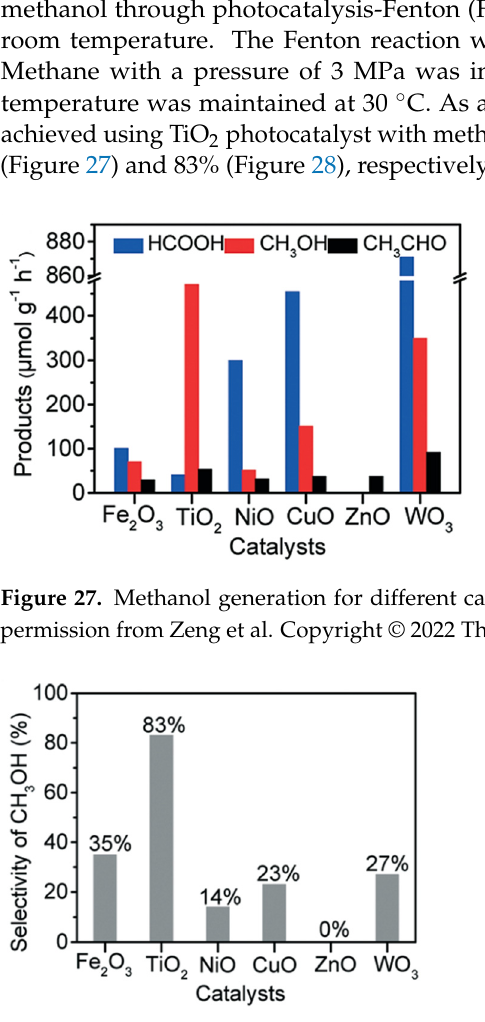
Figure 26. Yields of CH 3 OH in the photocatalytic oxidation of CH 4 in systems of different electron scavengers [88]. Reproduced with permission from Villa et al. Copyright © 2022 Elsevier.